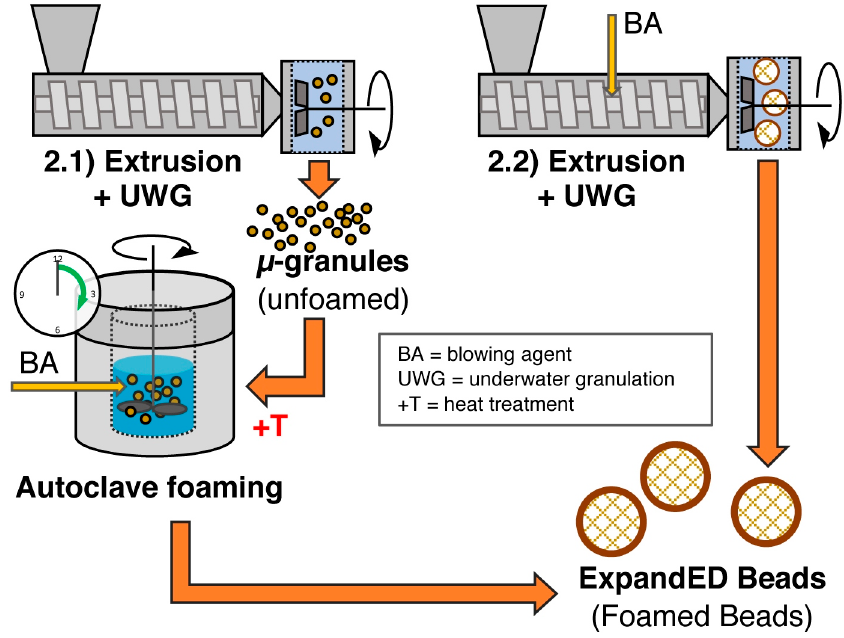
Figure 9. Overview of different methods to produce expanded bead foams.